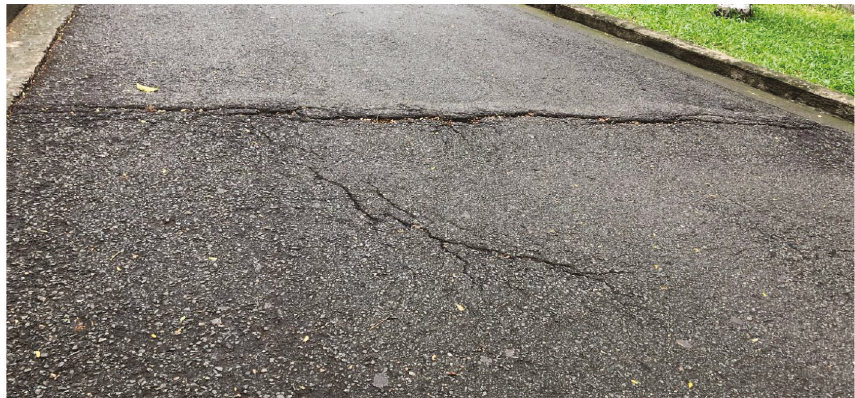
Figure 2: The target area including 2 cracks.